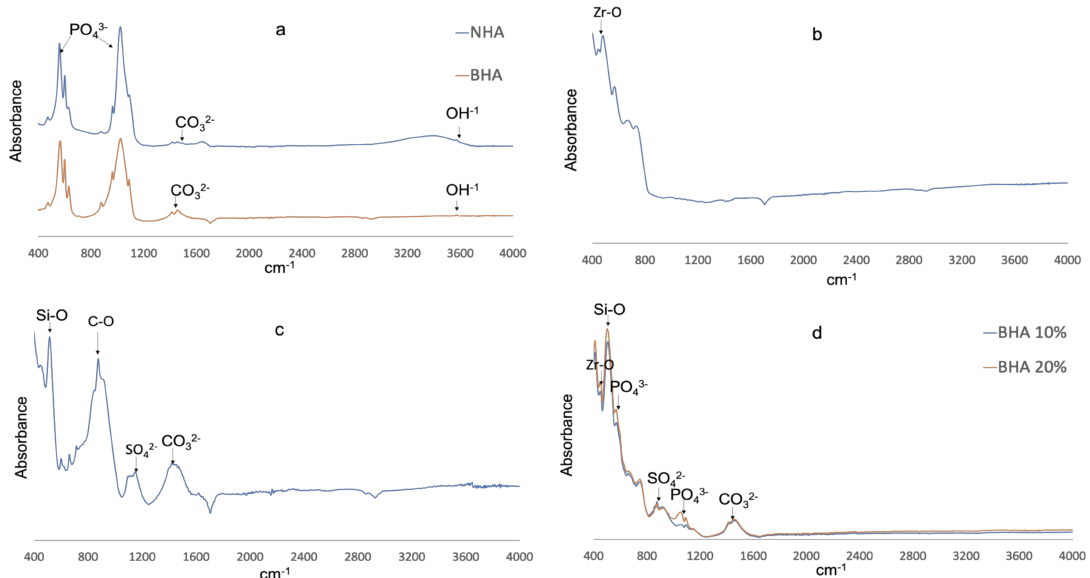
Figure 1. FTIR Spectra. ( a ) NHA (blue) and BHA (red). ( b ) Zirconia dioxide. ( c ) Portland cement. ( d ) BHA10% (blue) and BHA 20% (red).